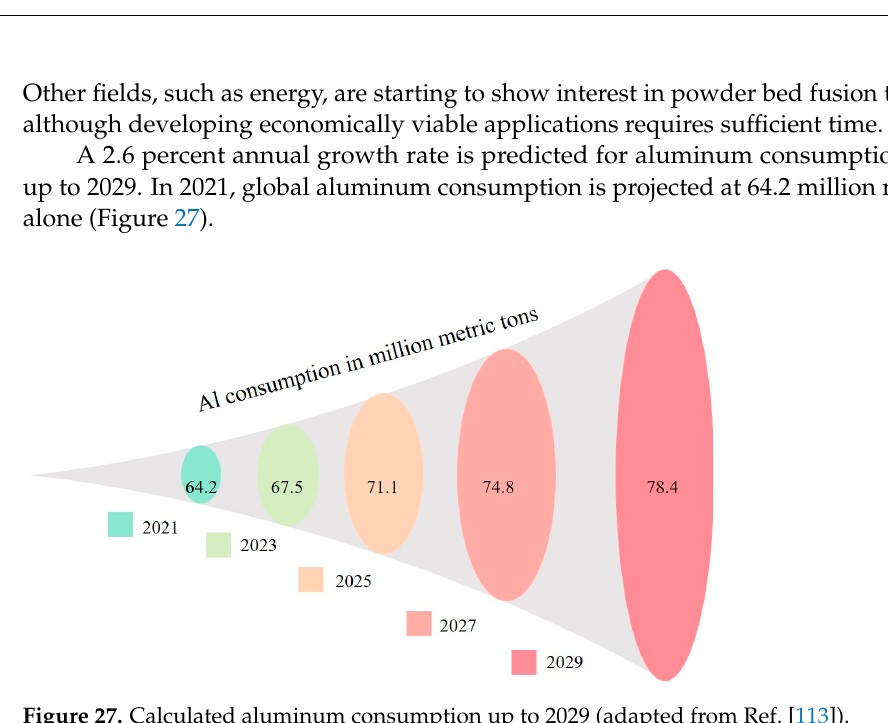
Figure 27. Calculated aluminum consumption up to 2029 (adapted from Ref. [113]).